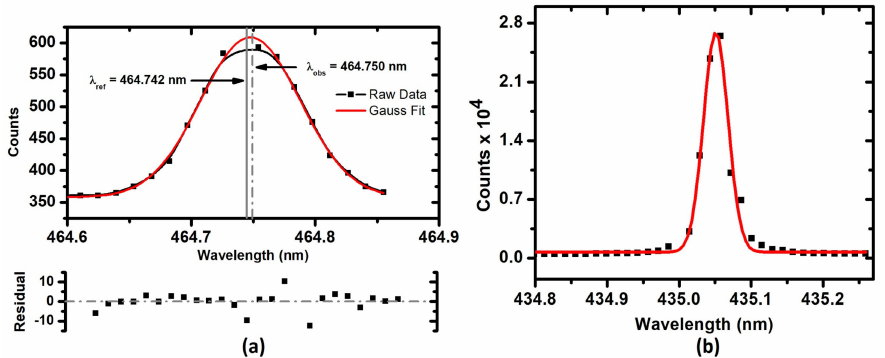
Figure 3. ( a ) Doppler shift measurement using C 2 + spectra, solid and dot-dashed line represents unshifted and shifted wavelengths respectively, ( b ) Gaussian fitted Hg spectrum at 435.8 nm to obtain instrumental